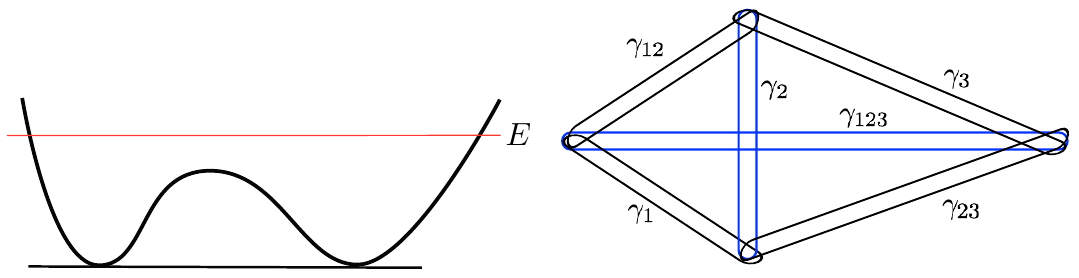
Figure 5 . In the case r = 3, the \maximal" chamber involves six TBA functions. This is the chamber relevant for a quartic potential in which the energy is above the potential barrier, as shown on the left. The TBA functions are associated to the cycles shown on the